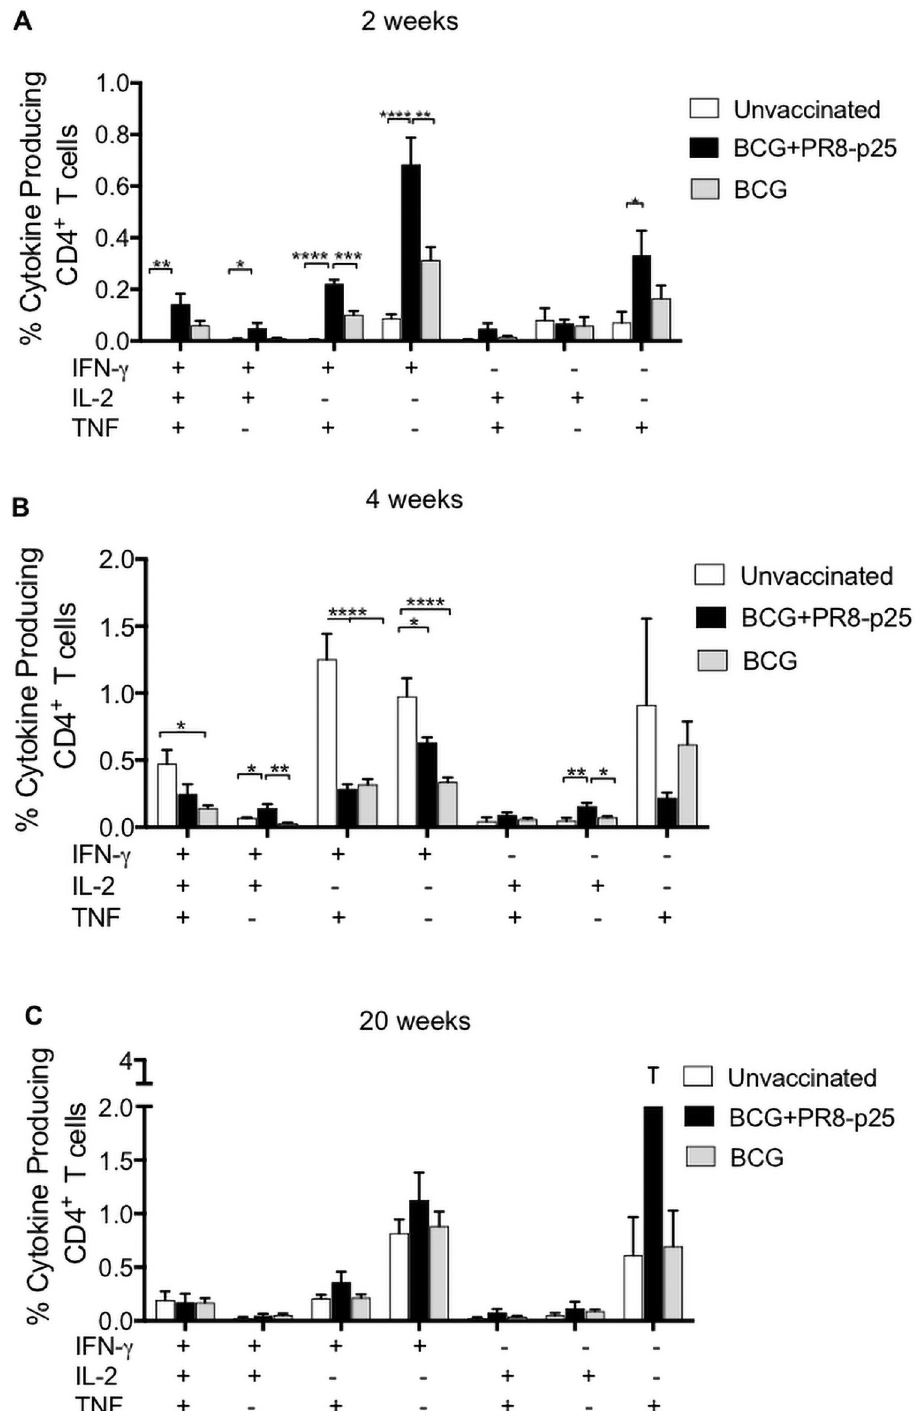
Fig 2. Cytokine production by p25-specific CD4 + T cells in the lungs after M . tuberculosis challenge. C57BL/6 mice (n = 5) were vaccinated simultaneously with s.c. BCG and i.n. PR8-p25, and challenged with M . tuberculosis as in Fig 1A. The lung cells from the same mice were stimulated with p25 antigen and then analyzed for intra-cellular cytokine production by flow cytometry. The frequency of p25-specific CD4 + T cells secreting IFN- γ , IL-2 and TNF at (A) 2, (B) 4, and (C) 20 weeks after challenge. Data are the means ± SEM. Statistically significant differences between groups were determined by one-way ANOVA ( � ) or Kruskal-Wallis ( # ) ( � p < 0.05; �� p < 0.01; ��� p < 0.001; ���� p < 0.0001).